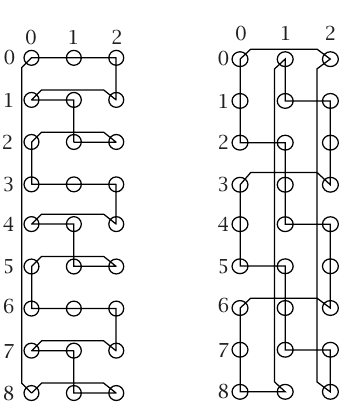
Figure 3.2 . Edge-disjoint Hamiltonian cycles in T